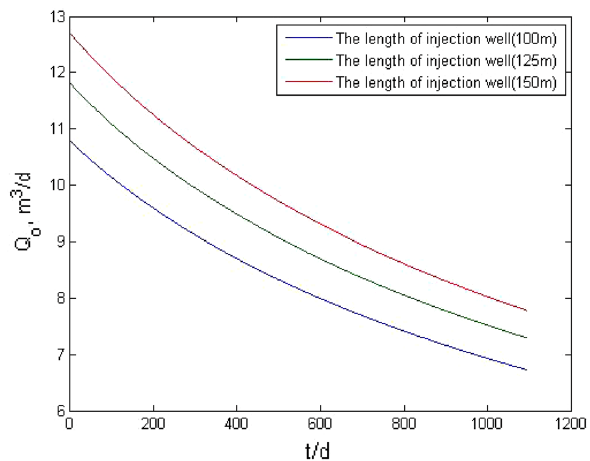
Fig. 8 Effects of fracture length of injection well on production